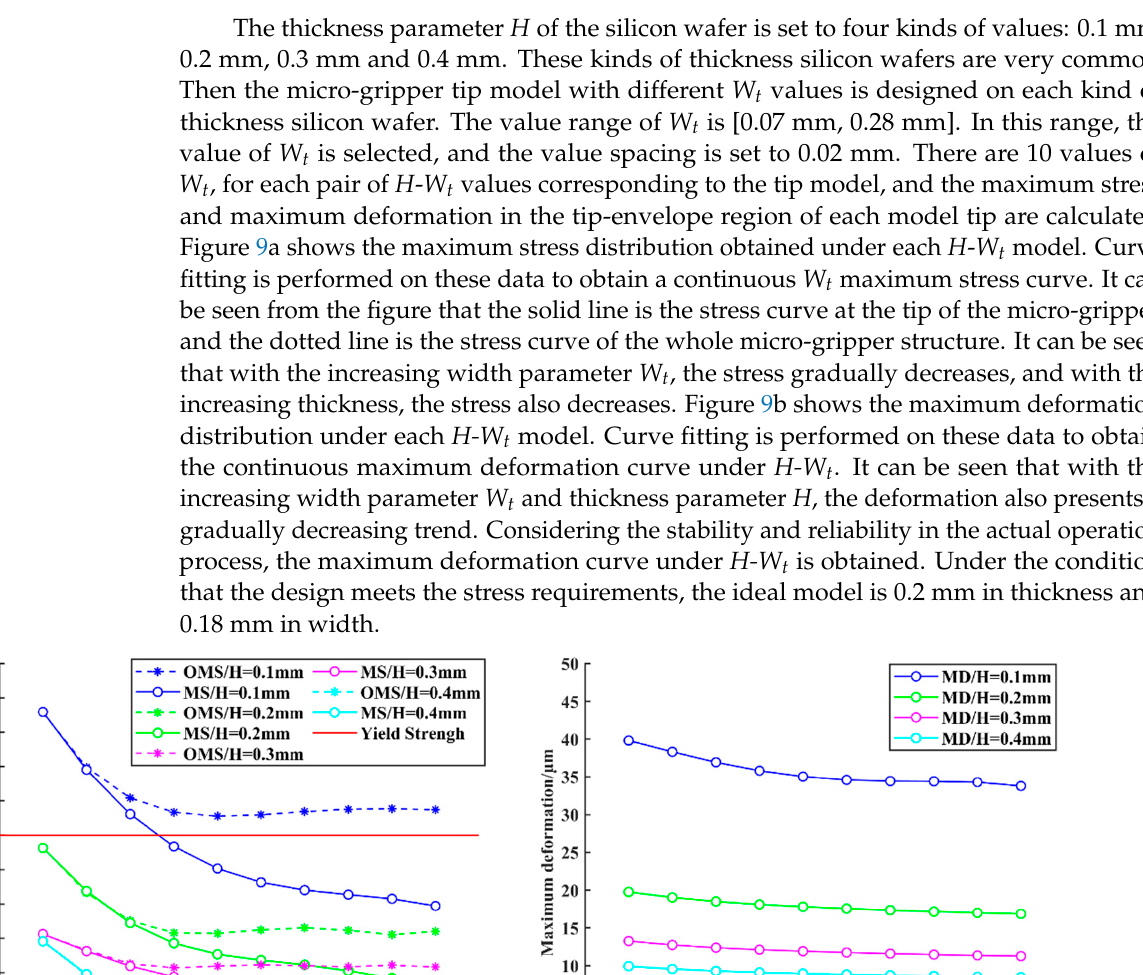
Figure 10. Diagram of the rotating eccentricity of the coreless motor winding.